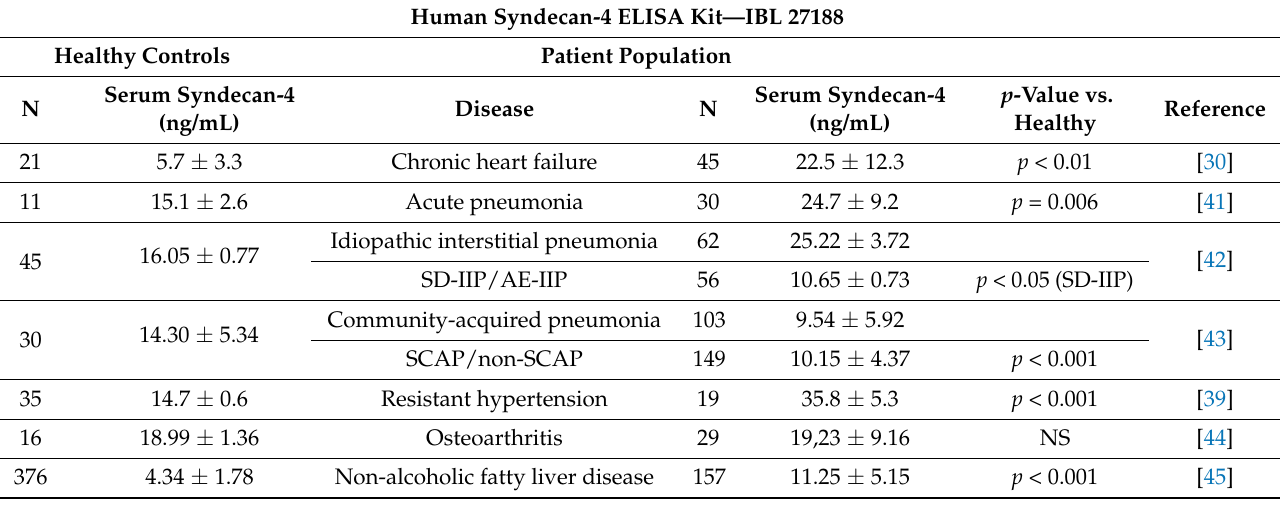
Table 1. Historical syndecan-4 levels in serum from patients and healthy controls. Human Syndecan-4 ELISA Kit—IBL